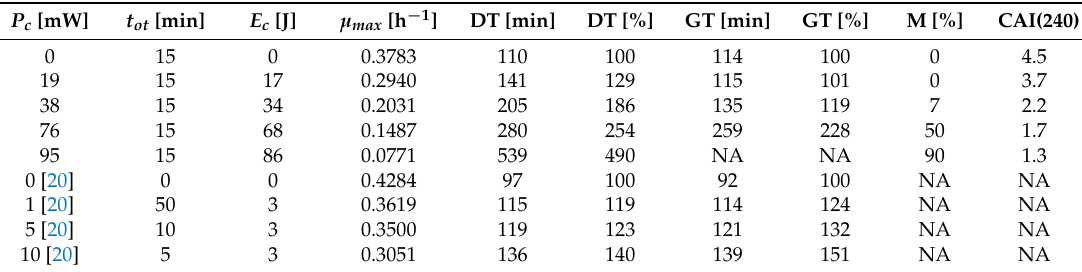
NA: Data not Figure 5. ( A ): Generation time ( GT ) of S. cerevisiae cells trapped for 15 min in optical tweezers with laser wavelength 1064 nm and trapping laser power P c in the range from 19 to 95 mW. The 0 mW point corresponds to the control unexposed cells; ( B ): mortality ( M ) of optically trapped S. cerevisiae cells under the experimental conditions identical to those in the generation time plot. On average, 13 samples were used for each data point. Error bars correspond to the standard error of the mean (SEM).